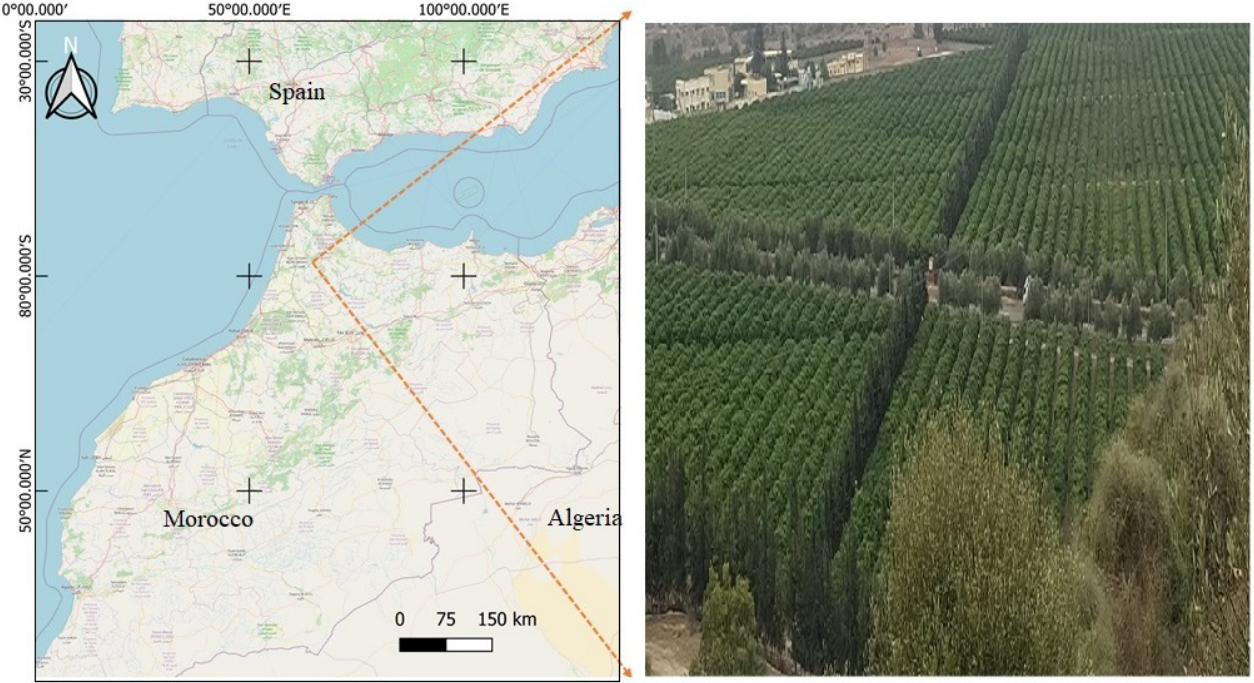
Figure 2. OUARGHA orchard - LES DOMAINES AGRICOLES (citrus